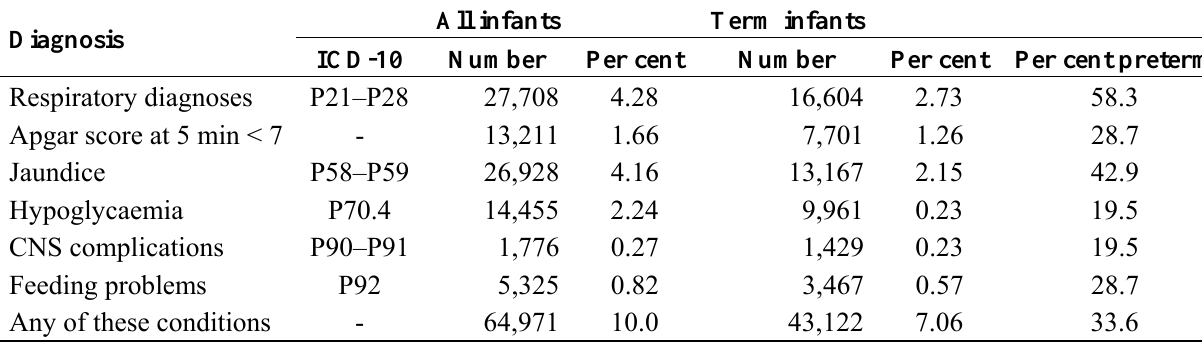
Table 5. Comparison of some major groups of neonatal morbidity in live born infants and in the subgroup of term infants ( n = 611,232, 94% of